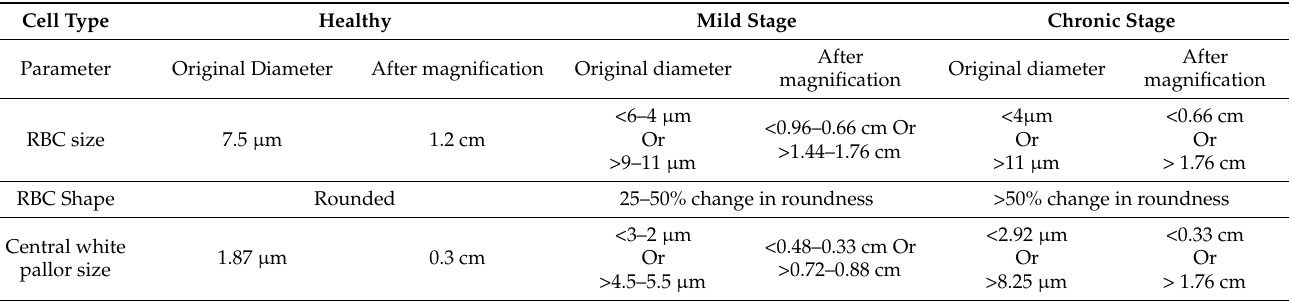
Table 3. Score range for the determination of anemia severity stages, i.e., Mild and Chronic. Column heading “Original diameter” represents the RBC size before magnification, while the column heading “After magnification” represents the size of RBC after